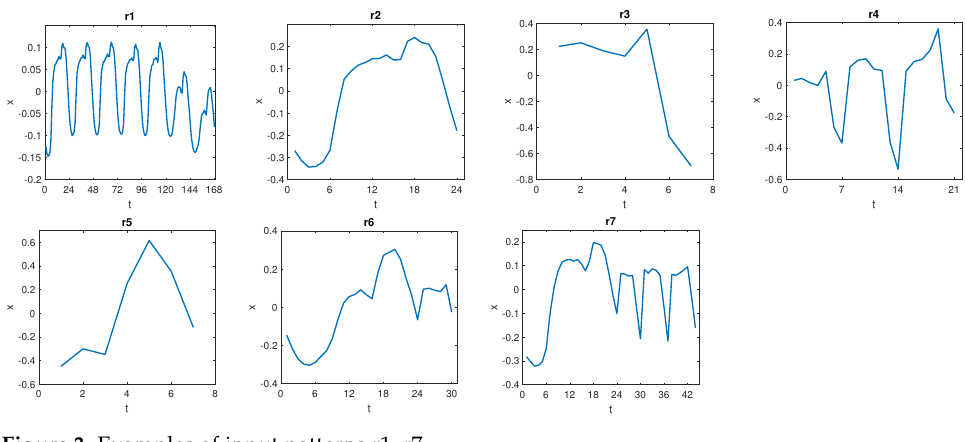
Figure 3. Examples of input patterns